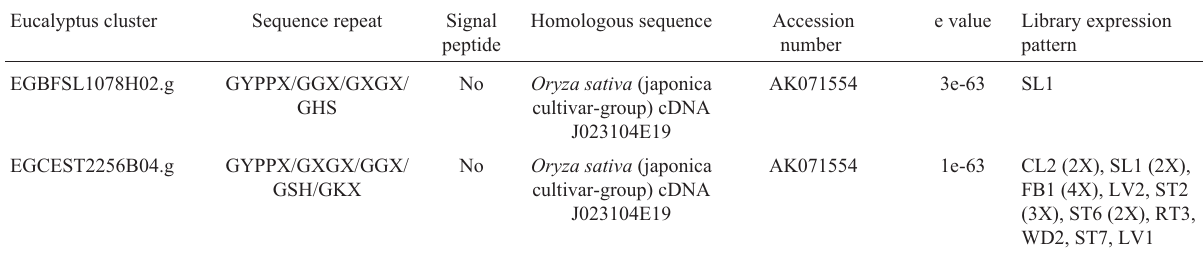
Table 6 - Eucalyptus ESTs encoding GRPs with a mixed pattern of